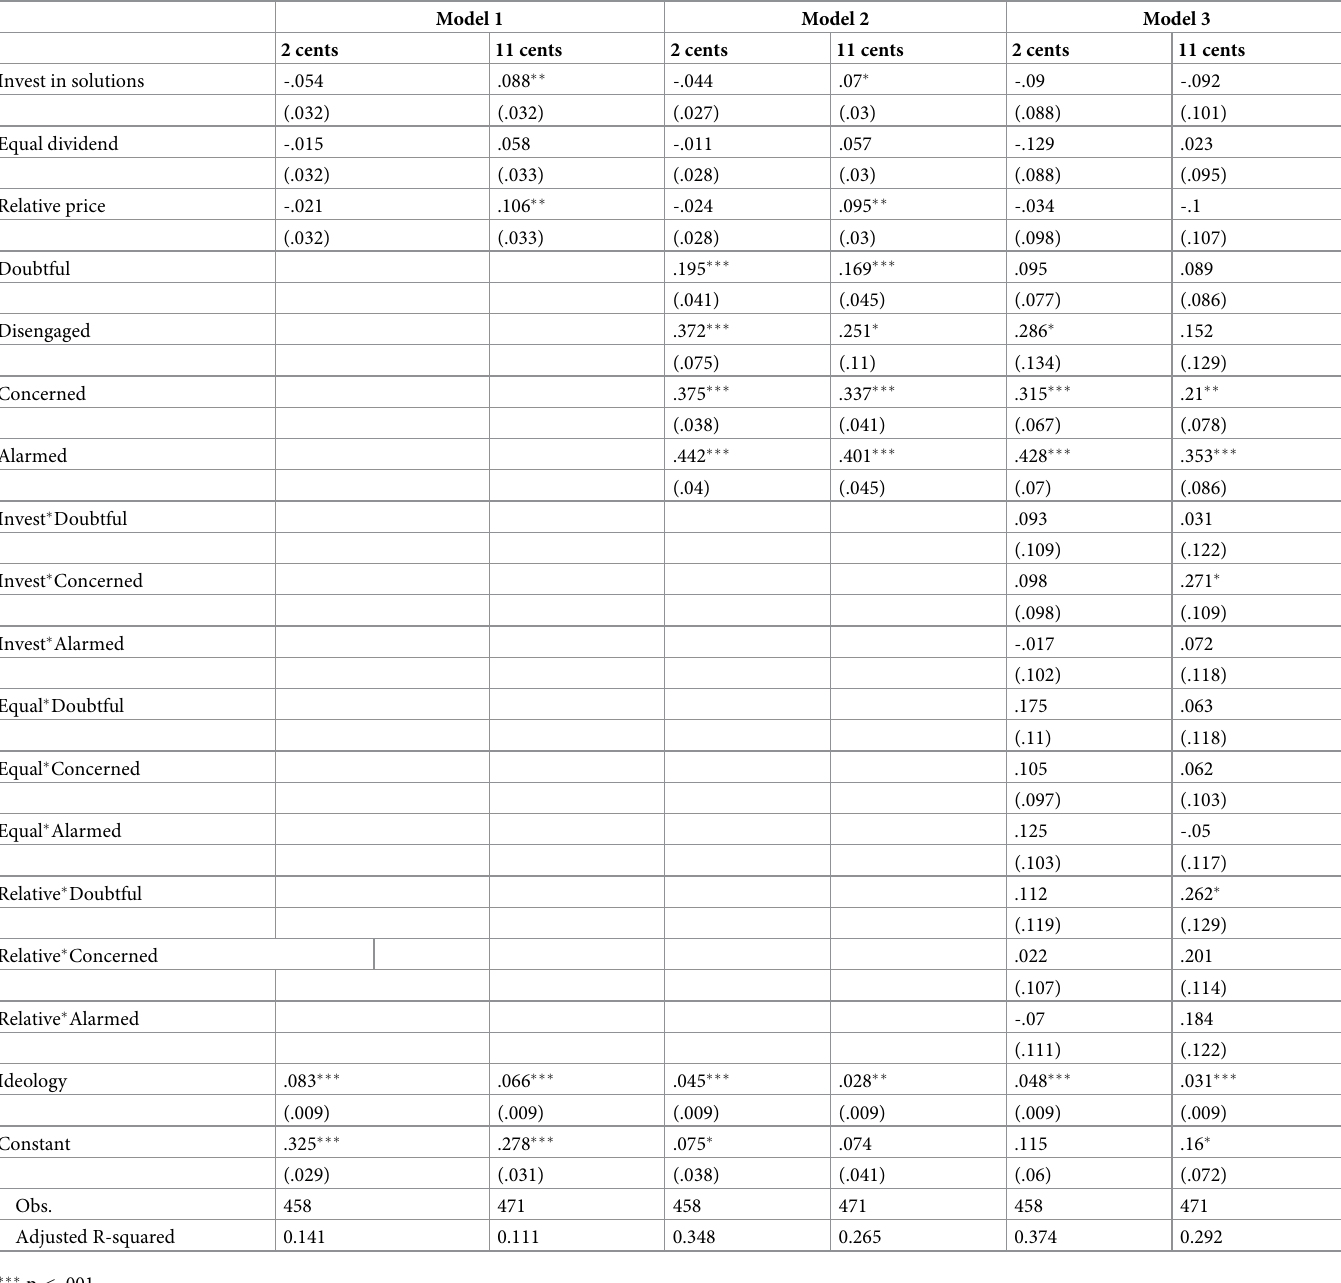
Table 5. Effect of emphasis framing on attitudes toward carbon taxes, conditional on the Five